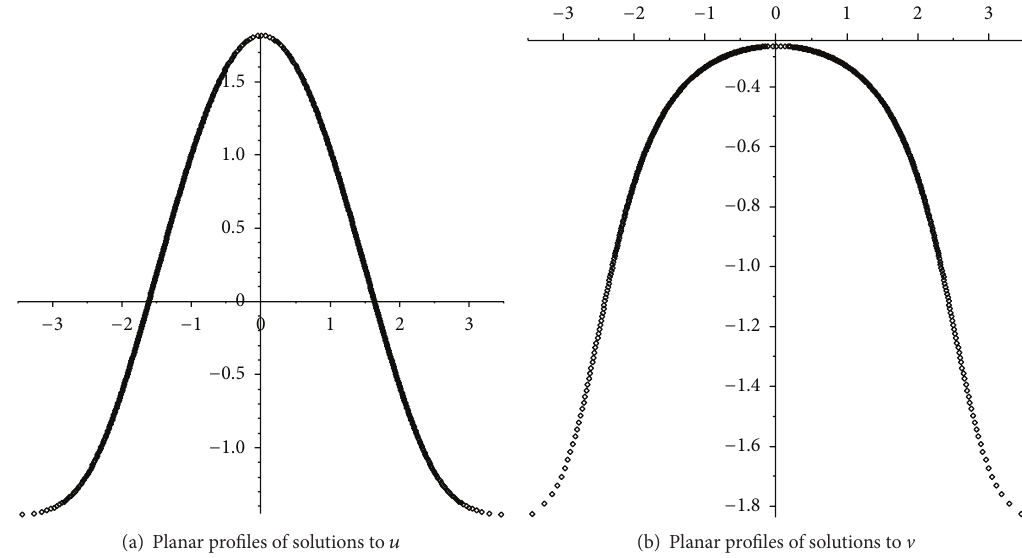
Figure 3: Smooth bell-shape solitary wave solution.